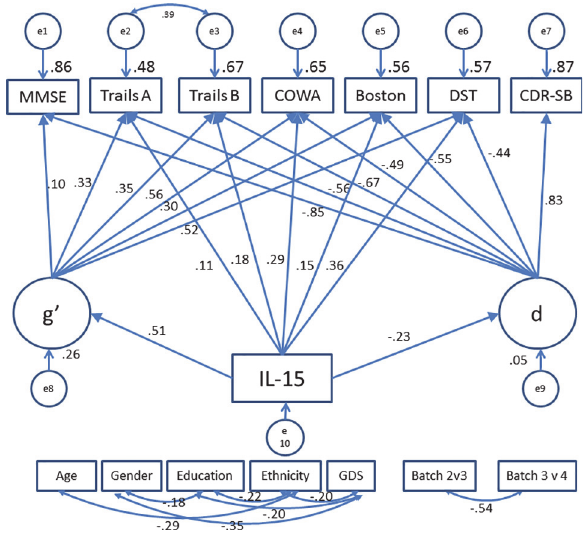
Fig 2. MIMIC Model. All observed variables were adjusted for age, gender, education, ethnicity and geriatric depression scale (GDS) scores (paths not shown for clarity). Abbreviations: BOSTON, Boston Naming Test; CDR-SB, Clinical Dementia Rating scale sum of boxes; COWA, Controlled Oral Word Association Test; DST, Digit Span Test; IL-15, Interleukin-15; MMSE, Mini-Mental Status Examination; Trails A, Trail Making Test A; Trails B, Trail Making Test B. Fit Indices: Chi Square: 85.196 (25); p (cid:1) 0.001; Comparative Fit Index (CFI): 0.995; Root Mean Square Error of Approximation (RMSEA): 0.035.